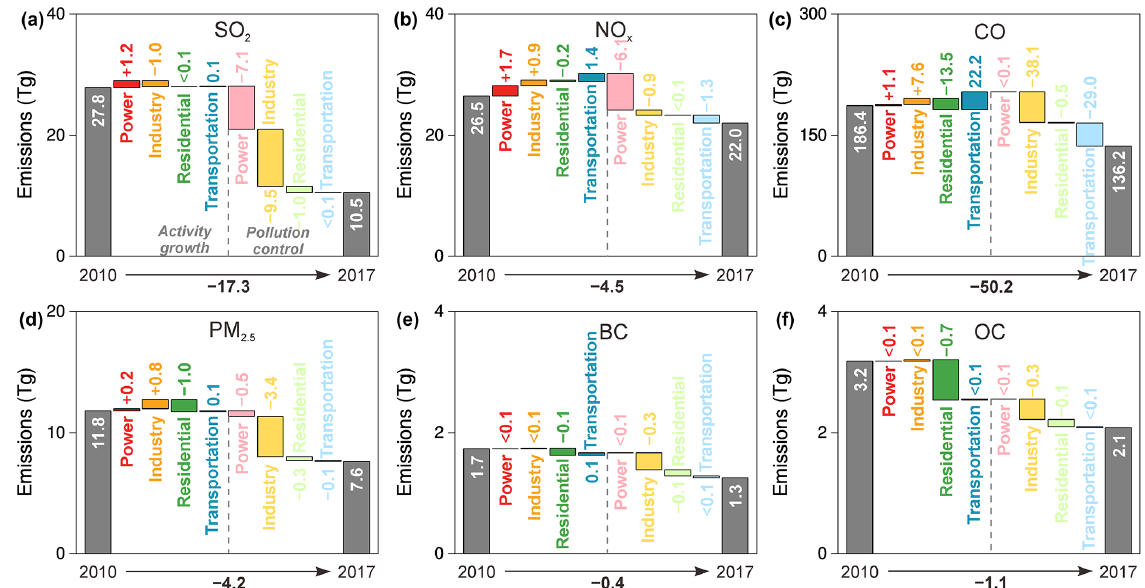
Figure 7. Drivers of emission changes for different emission species. The species plotted here include (a) SO 2 , (b) NO x , (c) CO, (d) PM 2 . 5 , (e) BC, and (f) OC. For each pollutant, the changes in emissions from 2010 to 2017 (bar) are decomposed into drivers of activity growth ( A in Eq. 2) and pollution control (the sum of x , E , and η in Eq. 2) by source sector.